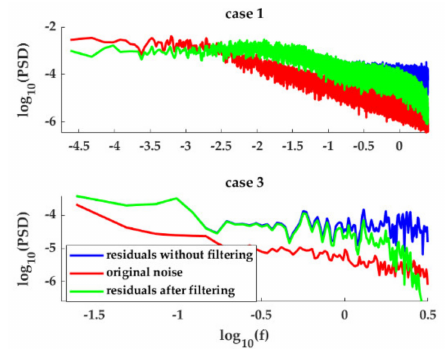
Figure 7. The PSD of the residuals for case 1 ( top ) and case 3 ( bottom ). The Hurst exponent for the simulated noise is H ref = 0.9. A plane is approximated with 1000 observations per line. Case with additional angle noise. The red curve corresponds to the PSD of the simulated noise, the blue curve to the PSD of the residuals and the green to the filtered